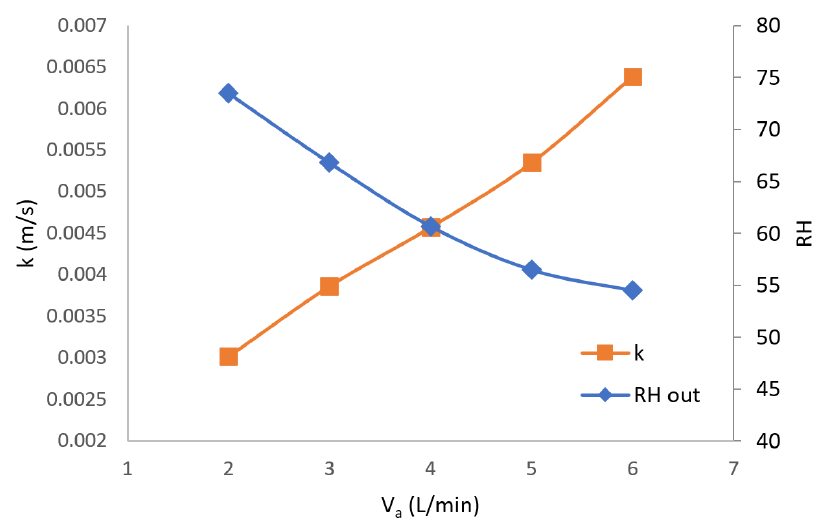
Figure 6. Convective mass transfer coefficient with varying airflow when no membrane used.